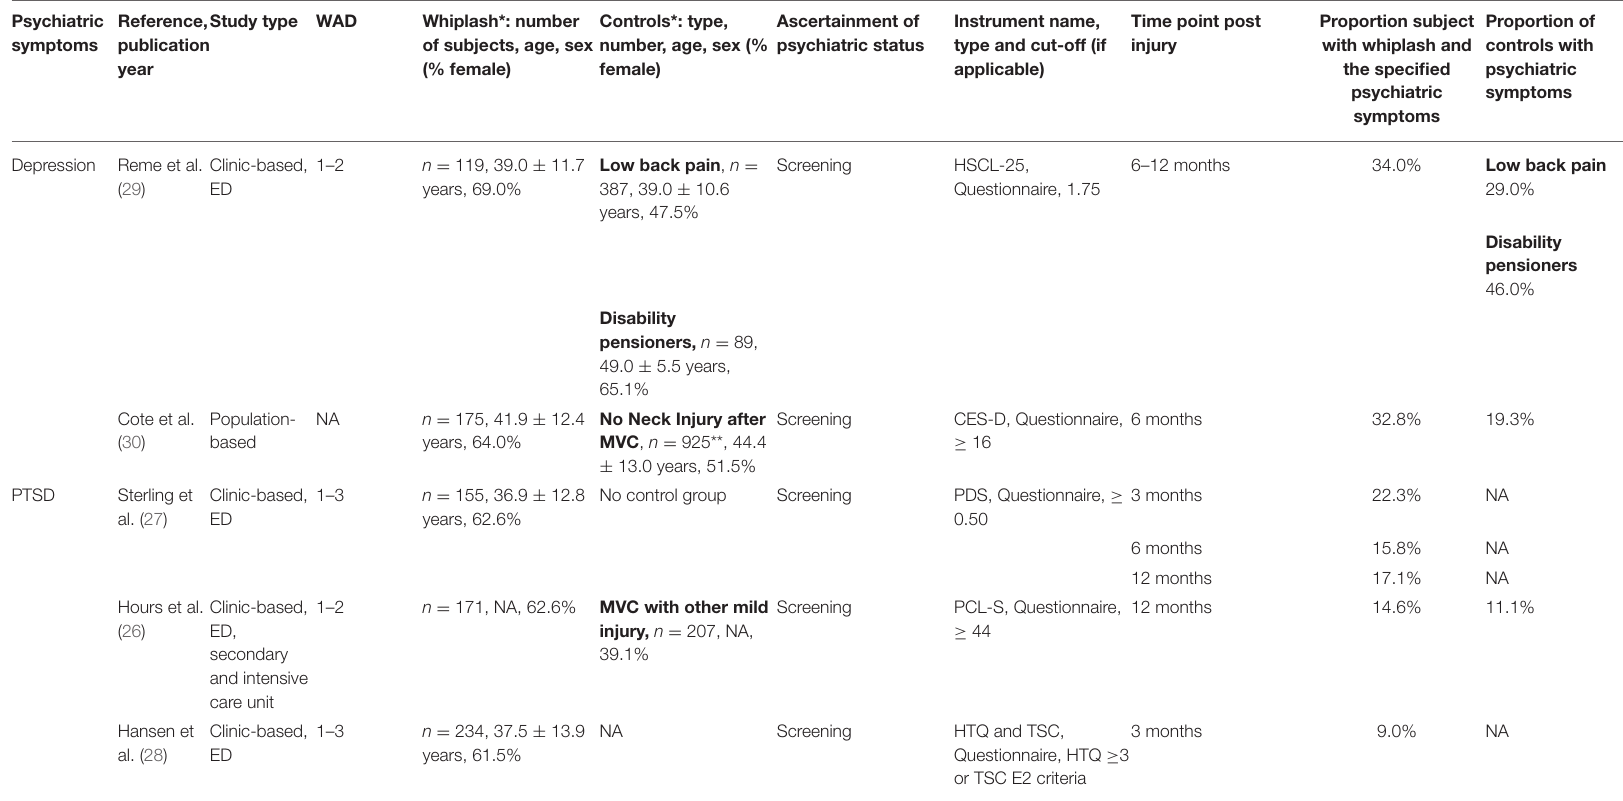
TABLE 2 | Overview of the included observational studies. Psychiatric Reference, symptoms